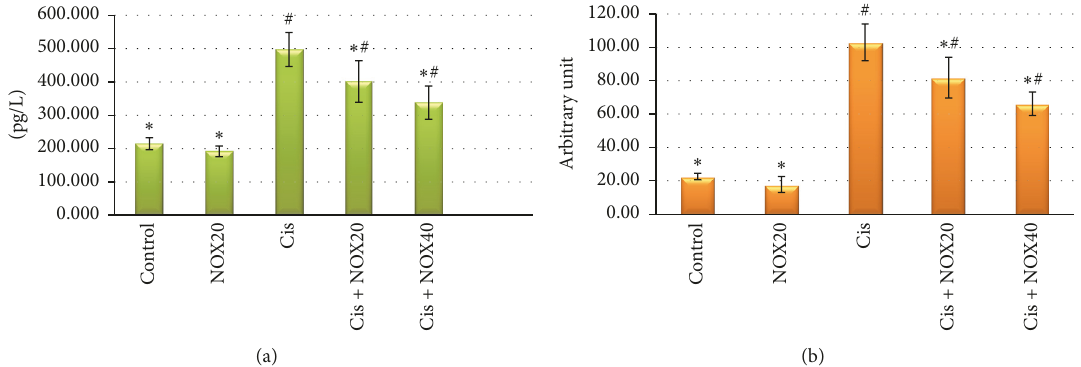
Figure 1: The effect of NOX on 8-OHdG (a) and DNA damage (comet assay) (b) levels in serum and PBMC of rats treated with Cis. Values are given as the means ± SD. There were no significant differences between the Cis and control groups in terms of any parameter ( 𝑝 > 0.01 ). # 𝑝 < 0.01 , compared with the control group. ∗ 𝑝 < 0.01 , groups in which Cis and NOX are treated together compared with the Cis